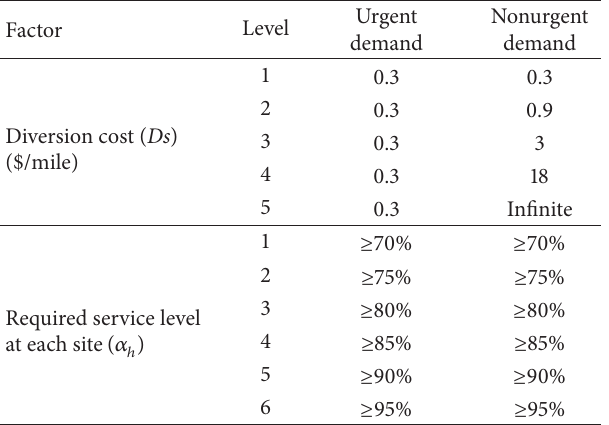
Table 1: Considered factors and their levels for problem set 1. Table 2: Considered factors and their levels for problem set 2.